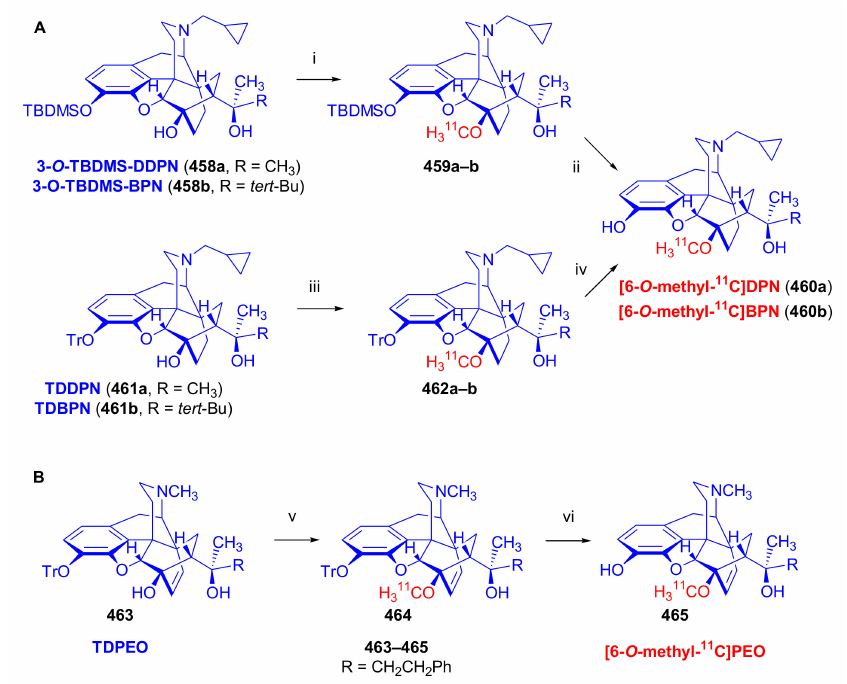
Figure 114. Synthesis of selected 11 C-labeled orvinol derivatives. A . Synthesis of [6- O -methyl- 11 C]DPN and [6- O -methyl- 11 C]BPN. B . Synthesis of [6- O -methyl- 11 C]PEO. Reagents and conditions